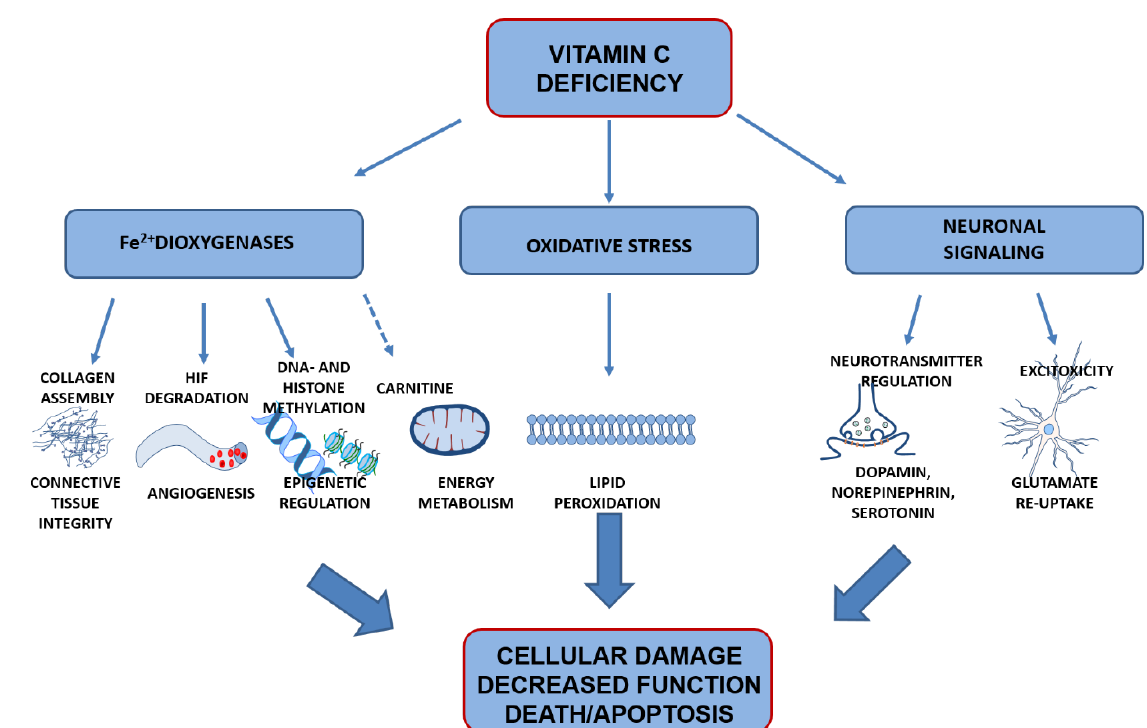
Figure 4. Overview of potential targets of vitamin C deficiency in the brain. Functions of vitC have not yet been completely disclosed and it is linked to several and different roles within the brain. The most well-known role is ensuring the hydroxylation and subsequent assembly of collagen in its triple helical structure. Failure to form functional collagen is seen during long-term and severe vitC deficiency and leads to the breakdown of connective tissue structures, e.g., in vascular walls, hallmarking scurvy. VitC is also linked to the formation of vasculature through hypoxia-inducible factors (HIFs). A lack of vitC may reduce hydroxylation and subsequently accumulation of HIF1 α , leading to deviated angiogenesis. In addition, oxidative stress may activate HIFs, thereby increasing levels further. Acting as co-factor in the regulation of methylation of nucleic acids, vitC deficiency is linked to alterations in DNA and histone methylation patterns and subsequent alterations in the epigenetic regulation of gene expression. VitC also acts as co-factor in carnitine synthesis and, though most likely due to alterations in excretion, carnitine deficiency is associated with low vitC status and consequent reductions in mitochondrial fatty acid metabolism, compromising cellular energy metabolism. In turn, accumulating reactive oxygen species and oxidative stress in vitC deficiency may lead to peroxidation of cellular membrane lipids, compromising cellular function and viability. Directly associated with neurotransmitter synthesis, vitC is a co-factor in the hydroxylation of dopamine, leading to norepinephrine, and provides reducing equivalents for tetra-hydrobiopterin necessary for the synthesis of dopamine and serotonin. Lastly, vitC deficiency reduces the re-uptake of extracellular glutamate, which in turn may lead to excitotoxic damage in the brain. Together, these functions of vitC highlights several likely effects of states of deficiency with putative serious consequences for cellular health and brain